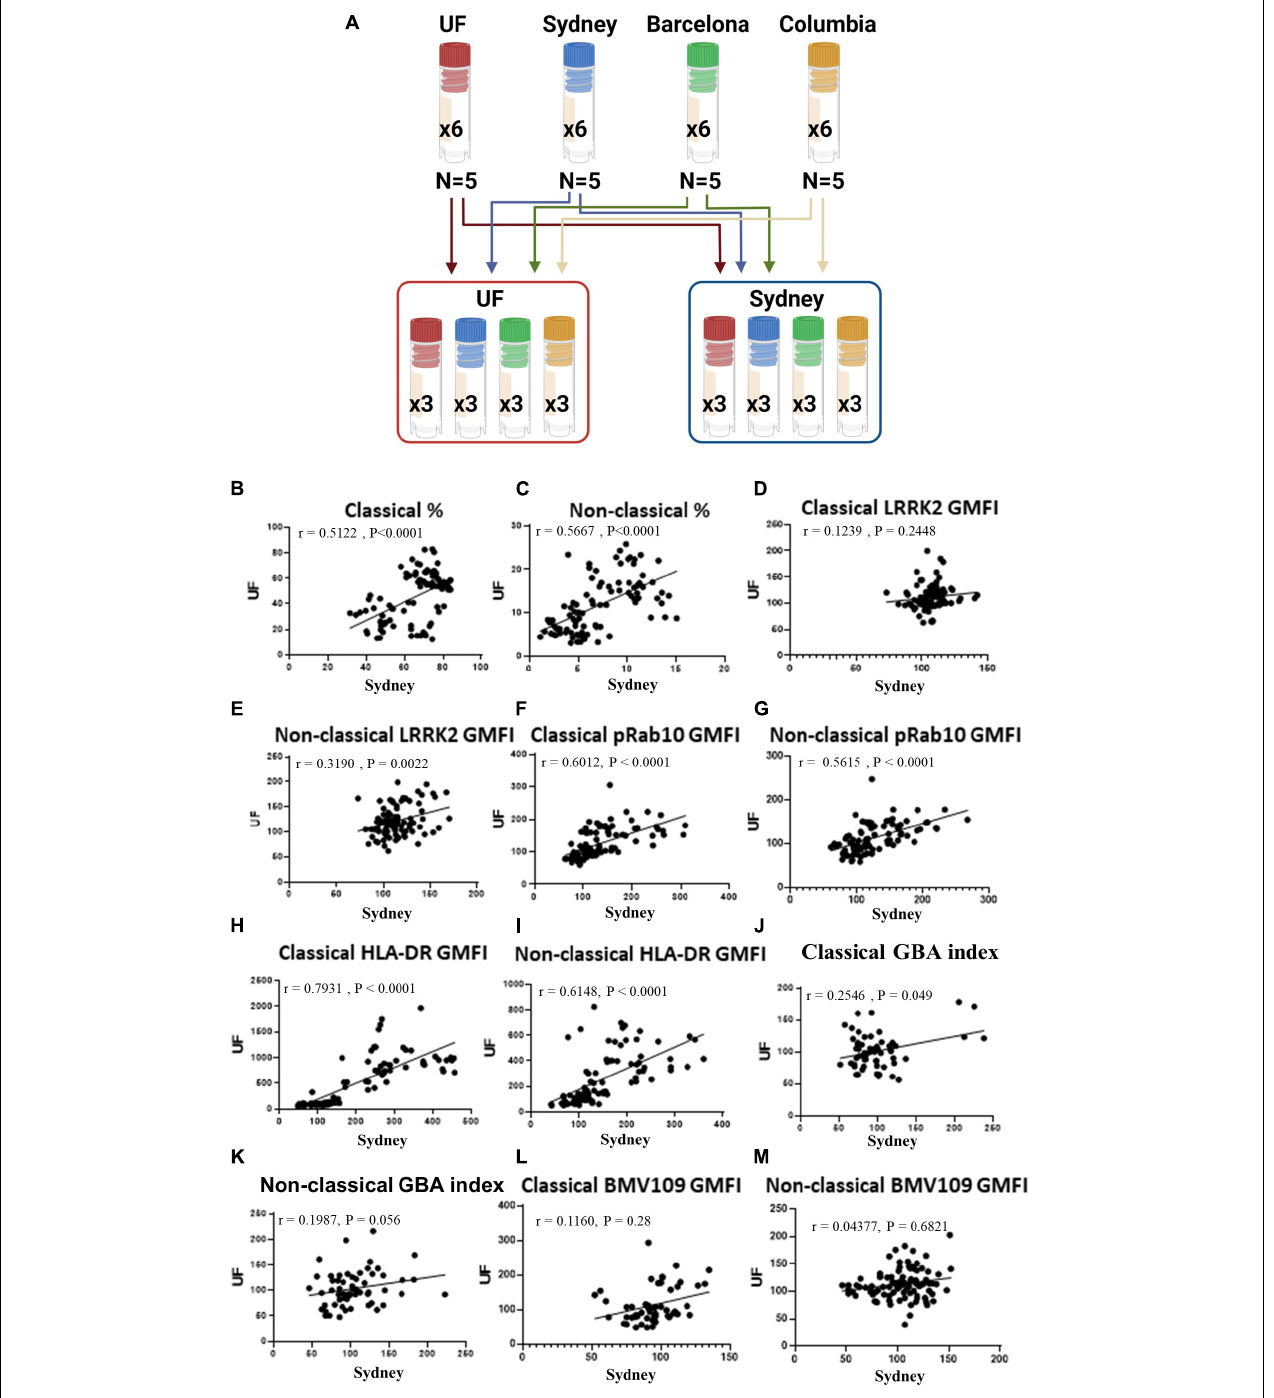
FIGURE 4 | WHOPPA affords reproducibility and consistency across research sites. Experimental approach (A) . PBMCs from the same healthy controls were plated and assessed via WHOPPA at both the University of Florida and the University of Sydney and readouts from these two locations plotted against each other to determine consistency across research sites. (B) Frequency of classical monocytes [r(31) = 0.5122, p < 0.0001], and (C) non-classical monocytes were plotted [r(41) = 0.5677, p < 0.0001]. (D) LRRK2 GMFI in classical [r(1) = 0.1239, p = 0.2448] and (E) non-classical monocytes were plotted [r(10) = 0.3190, p = 0.0022]. (F) pRab10 GMFI in classical [r(49) = 0.6012, p < 0.0001] and (G) non-classical monocytes were plotted [r(40) = 0.5615, p < 0.0001]. (H) HLA-DR GMFI in classical [r(149) = 0.7931, p < 0.0001] and (I) non-classical monocytes were plotted [r(53) = 0.6148, p < 0.0001]. (J) GBA index in classical [r(5) = 0.2546, p = 0.049] and (K) non-classical monocytes were plotted [r(3) = 0.1987, p = 0.056]. (L) BMV109 GMFI in classical [r(1) = 0.1160, p = 0.2761] and (M) non-classical monocytes were plotted [r(1) = 0.04377, p = 0.2123]. Pearson r was used to assess individual correlations of slopes of HC and PD.